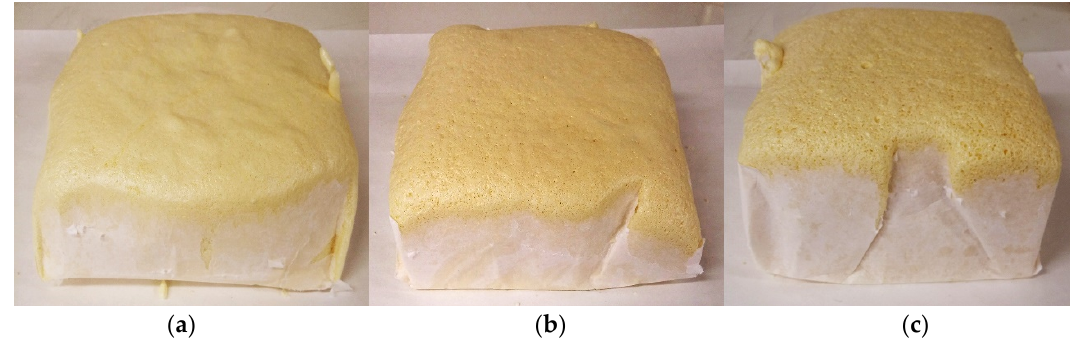
Figure 3. Photograph of the RPU foams containing a 20 wt% of microcapsules synthesized at different operating pressures: ( a ) atmospheric; ( b ) 800 mbar, and ( c ) 700 mbar.